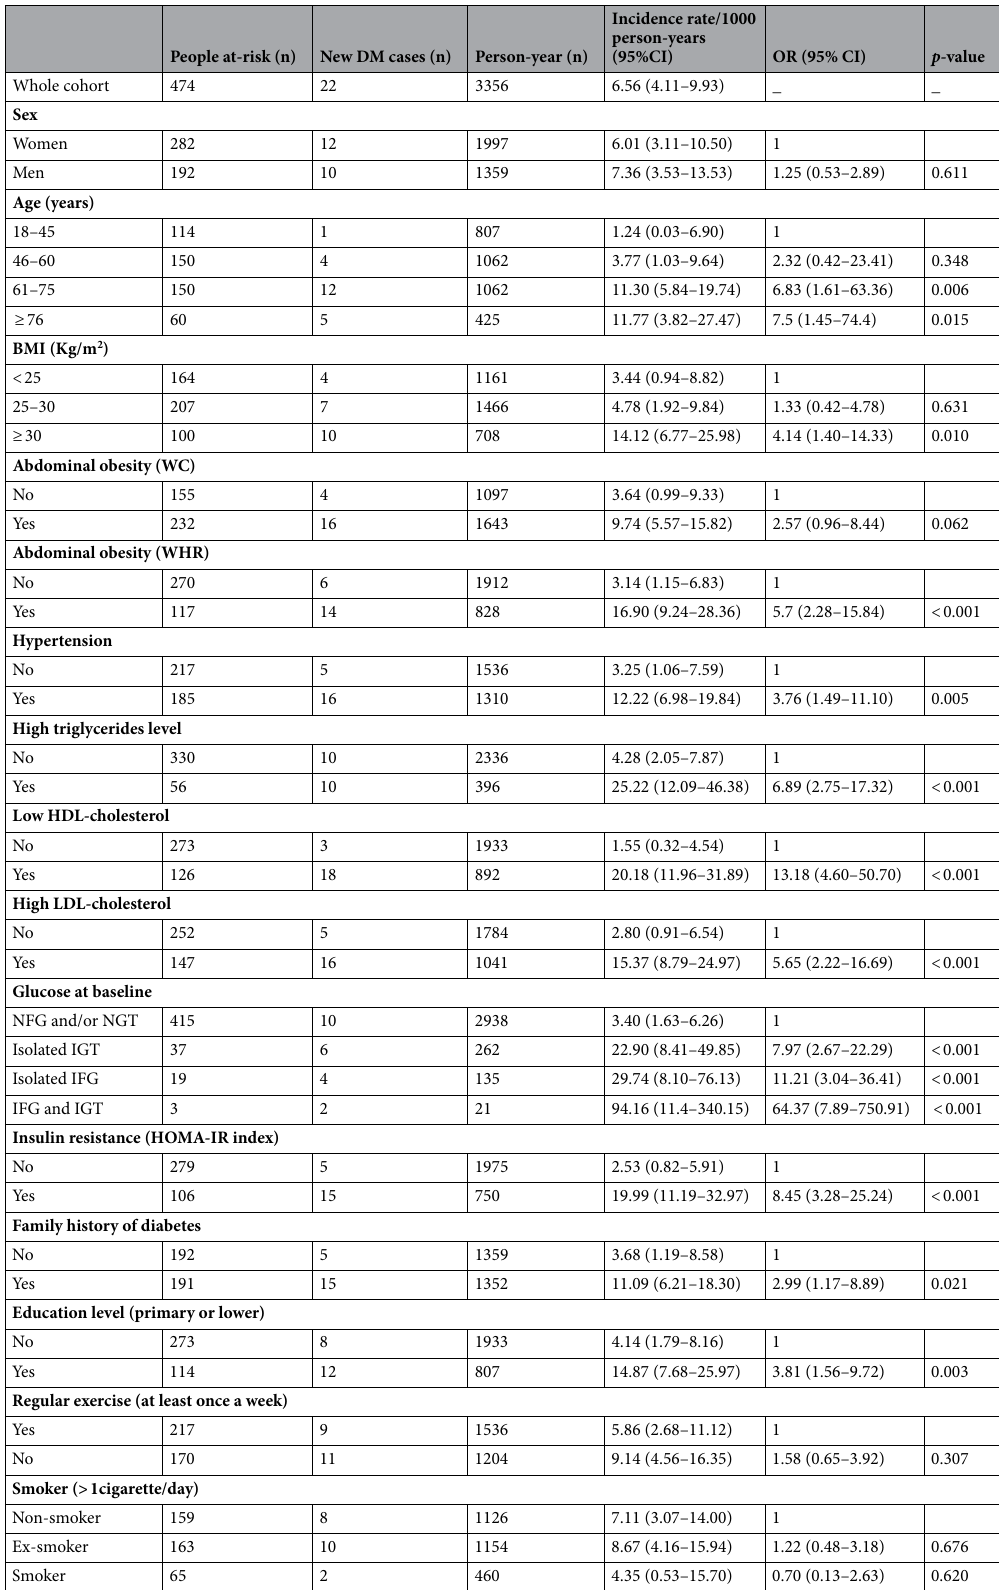
Table 2. Diabetes incidence rates and OR (95% CI) for diabetes according to possible risk factors. People at risk were those without diabetes in the prevalence study (2010–2012). Family history of diabetes defined as 1st or 2nd degree relatives with diabetes. Definitions of the rest of cardiovascular risk factors are detailed in methods. OR (95%CI) were calculated for each variable by univariate binomial logistic regression